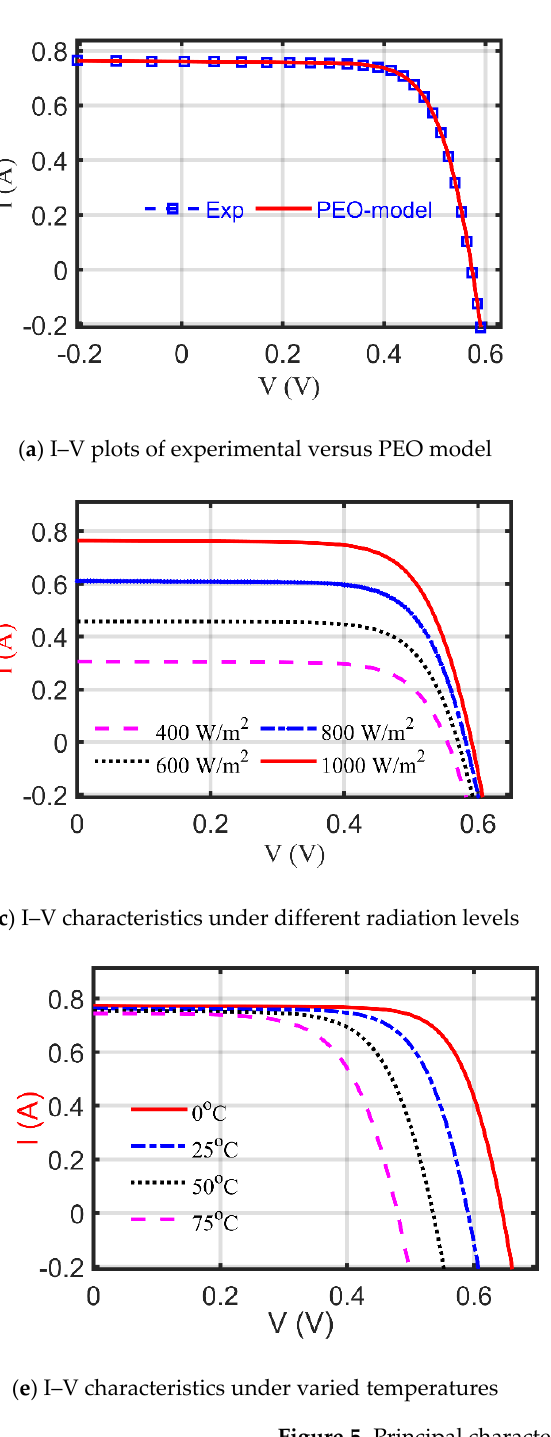
Figure 5. Principal characteristics of RTC France Si solar cell.